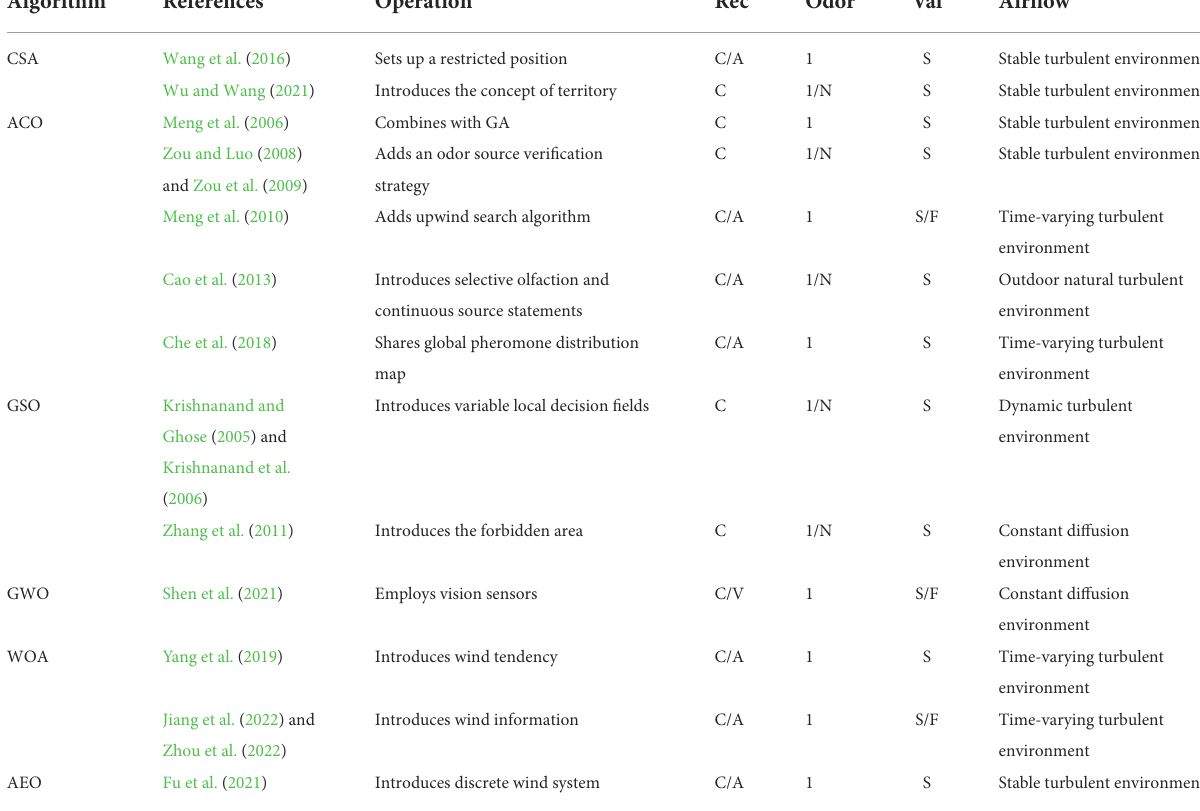
TABLE 3 Summary of other nature-inspired SI algorithms applied to odor source